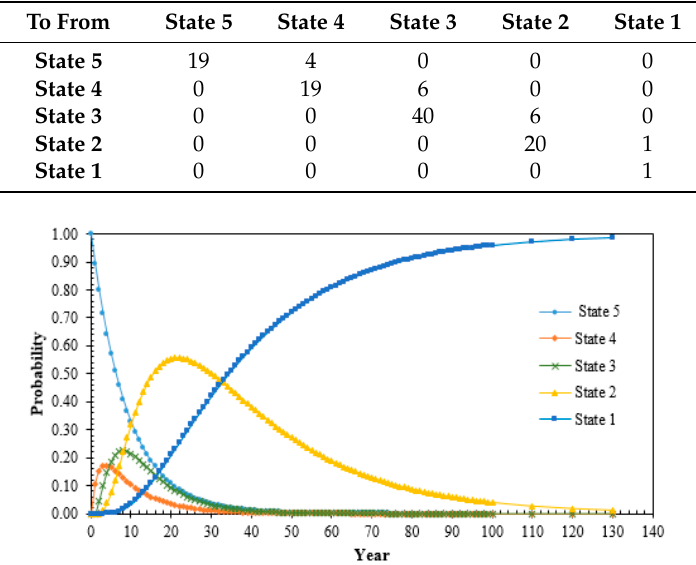
Figure 4. State probabilities in the year 2015 based on transformer transition states for the year 2013/2014.